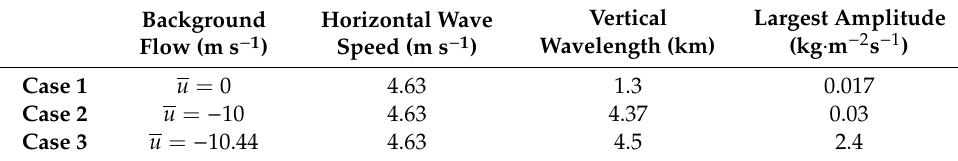
Table 1. Parameters of the forced gravity waves for three different background flows.